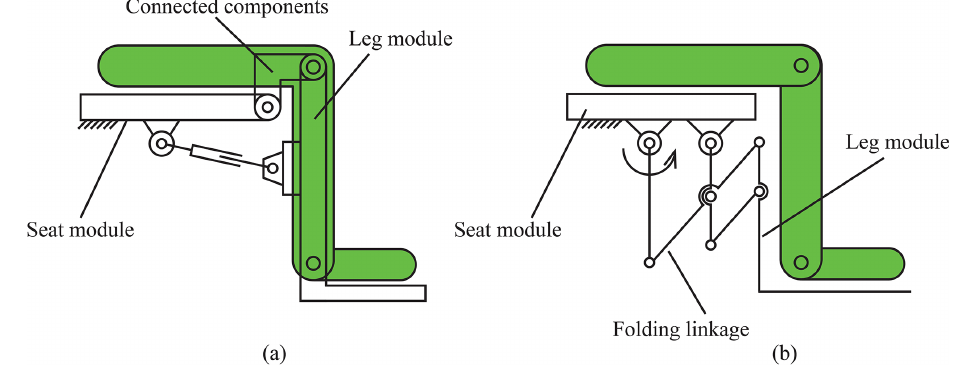
Figure 5. The general configuration of the leg module. (a) Configuration I. (b) Configuration II.